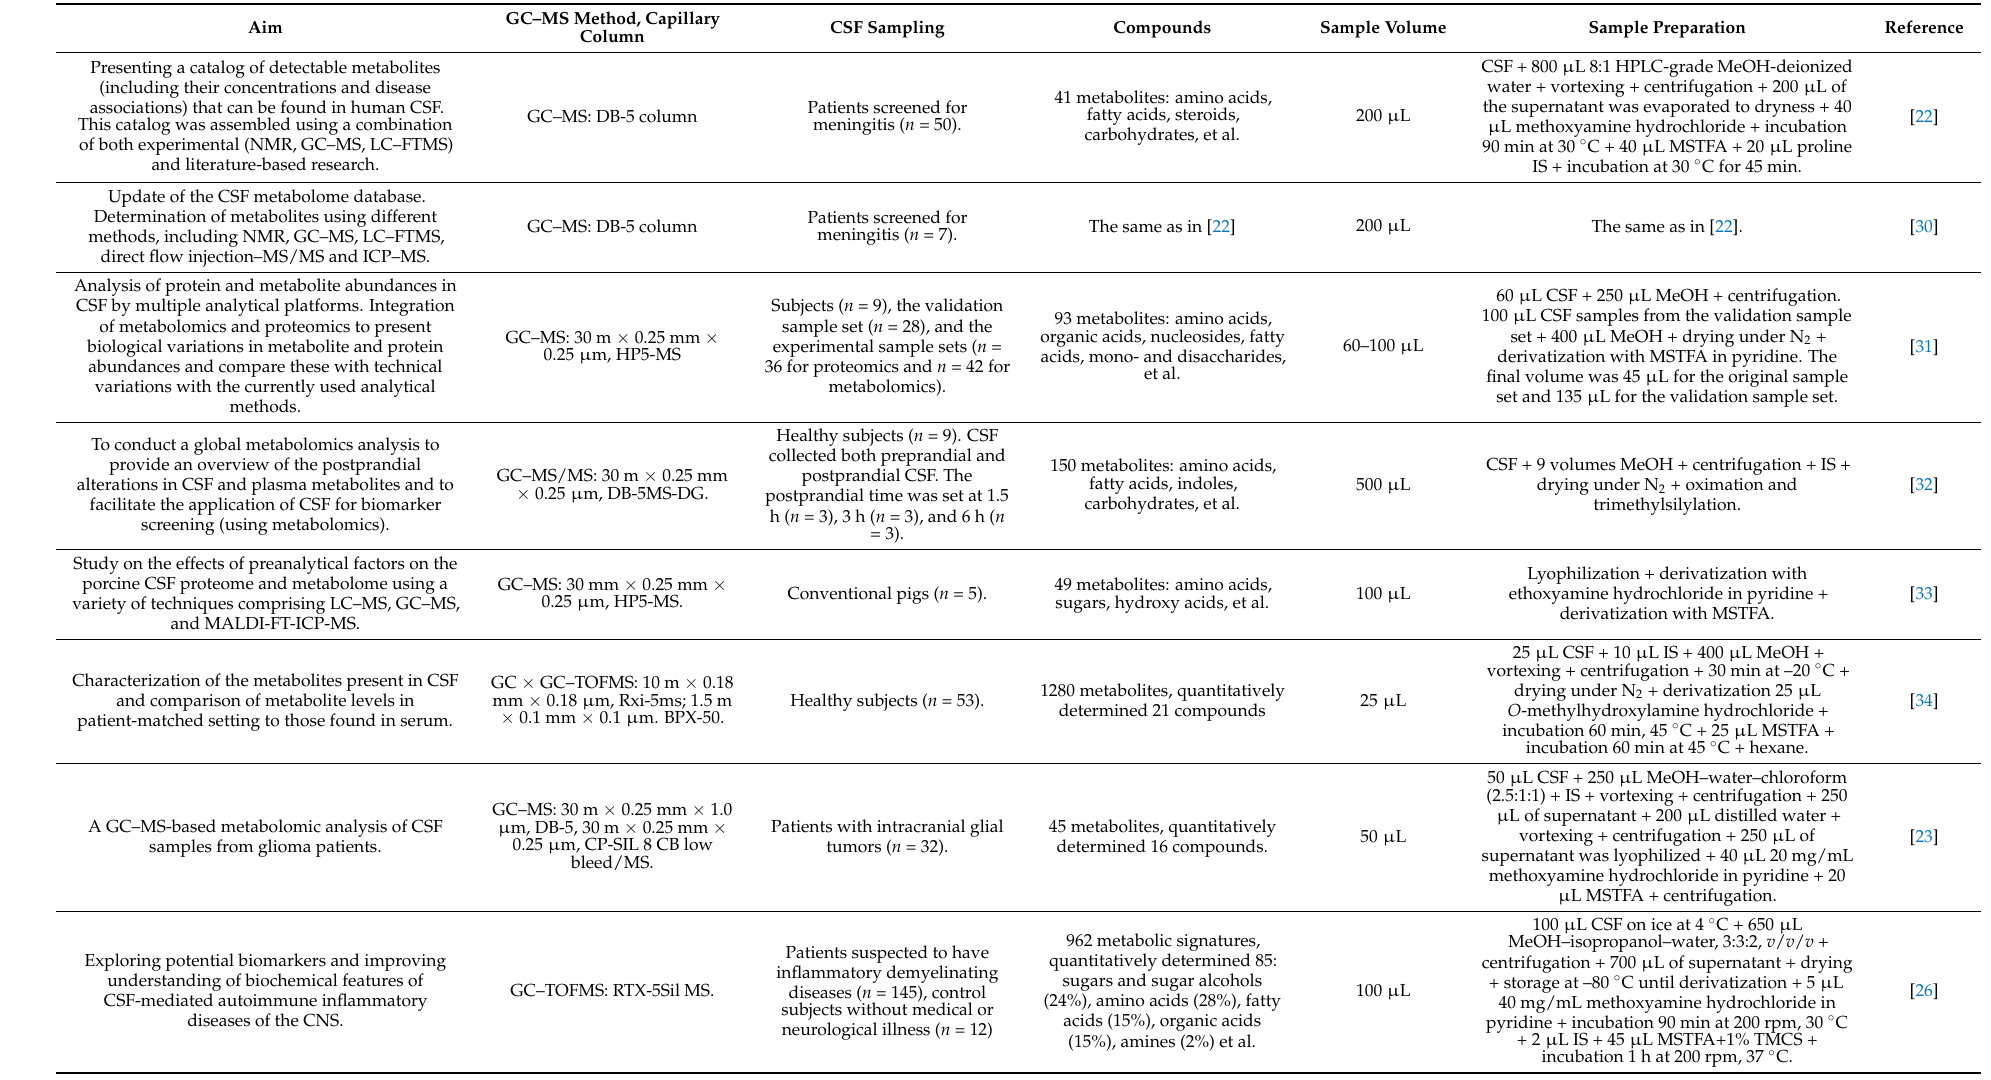
Table 1. The CSF metabolic profiling using GC–MS methods (CSF volume, samples preparation, and type of capillary